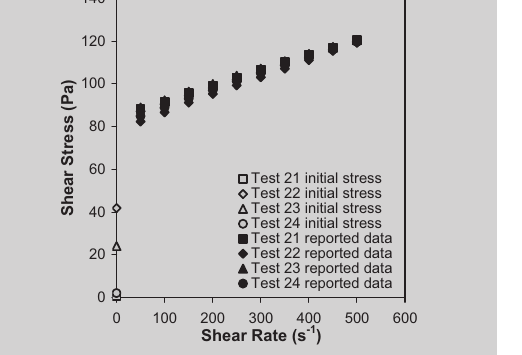
Figure 4 (left): Shear stress-shear rate sweeps for a 0.56 w/w nick- el laterite suspension using a Haake rheometer (MV1P bob and MV1 Cup) with a measurement mode of 12 seconds per point and the torque auto zero disabled. Grey filled data points indi- cate the stress acting on the fixture immediately before the start of the test. Figure 5: Shear stress-shear rate sweeps for a 0.56 w/w nick- el laterite suspension using a Haake rheometer (MV1P bob and MV1 Cup) with a measurement mode of 12 seconds per point and the torque auto zero